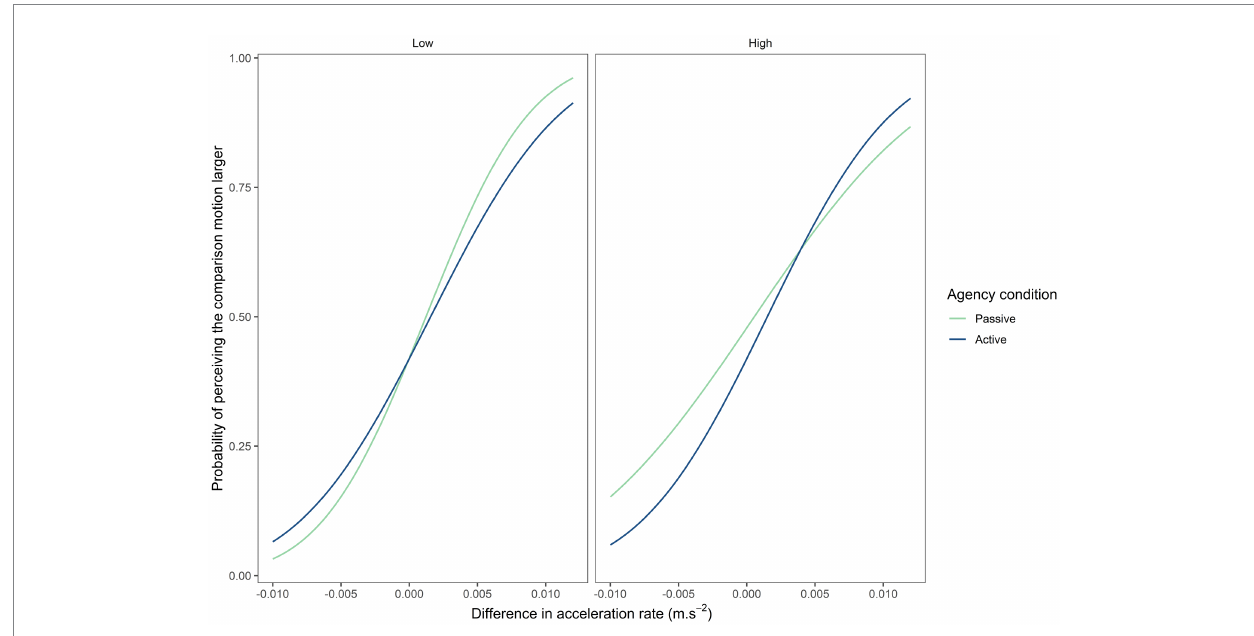
FIGURE 3 Psychometric curve depending on level of motion ambiguity and agency